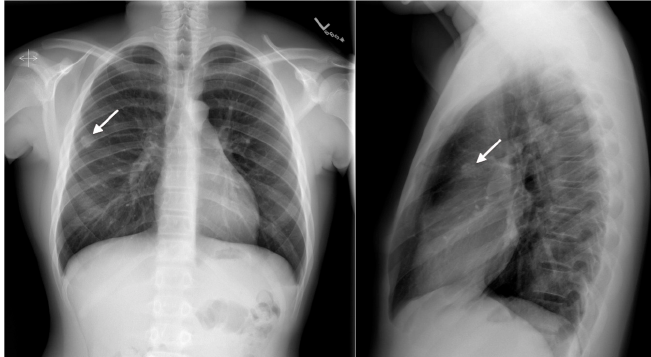
Figure 1. Anterior-Posterior chest radiograph on index visit showing a 1.3 cm right upper lobe density (arrows).